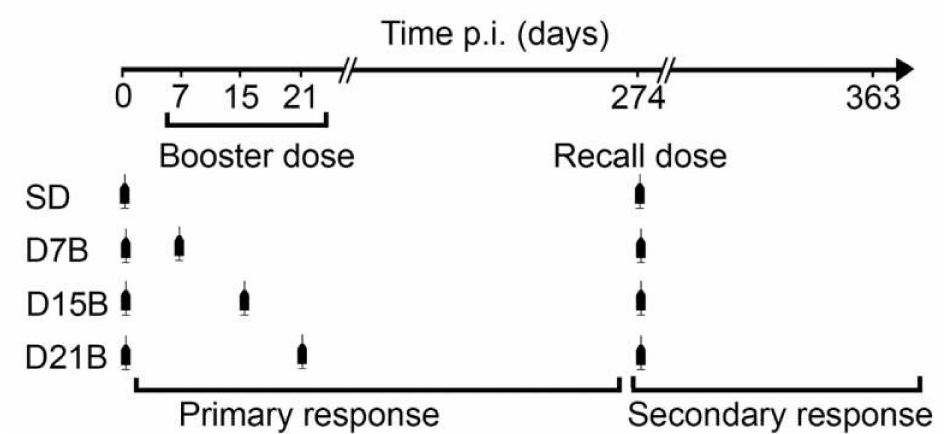
Figure 1. Experimental design for the identification of a consolidation phase in immunological memory (Figure 1 in [10]). The single-dose (SD) control group received a single dose of vaccine fdAD(2-6). Other treatment groups also received a booster dose, respectively, at day 7 (D7B), day 15 (D15B), and day 21 (D21B) after the first dose. All mice received a recall dose 9 months after the first dose and were monitored for 3 more months. Primary response is defined as the response initiated by the first dose of vaccine (days 0–274 post immunization), secondary response is defined as the response initiated by the recall dose (days 274–363 post immunization). In all groups n =